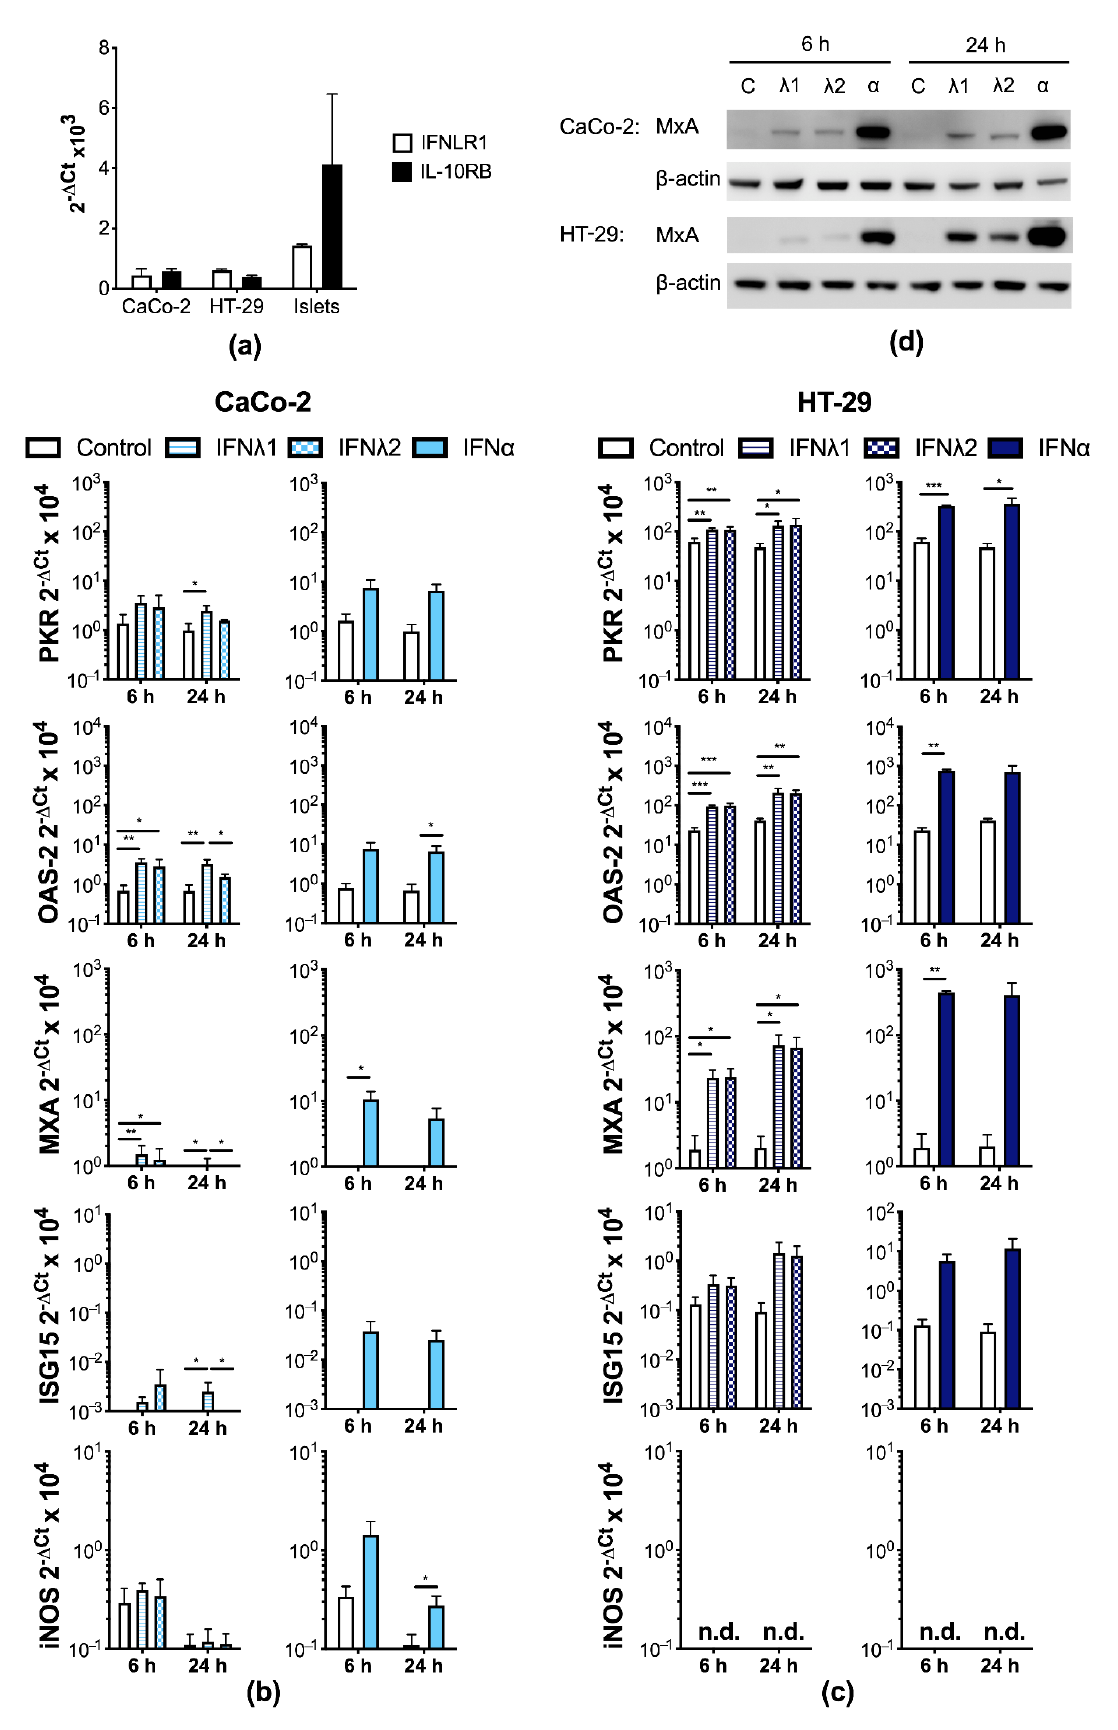
Figure 2. Intestinal epithelial cells (IECs) respond to Type I and III interferons (IFNs) through the up-regulation of